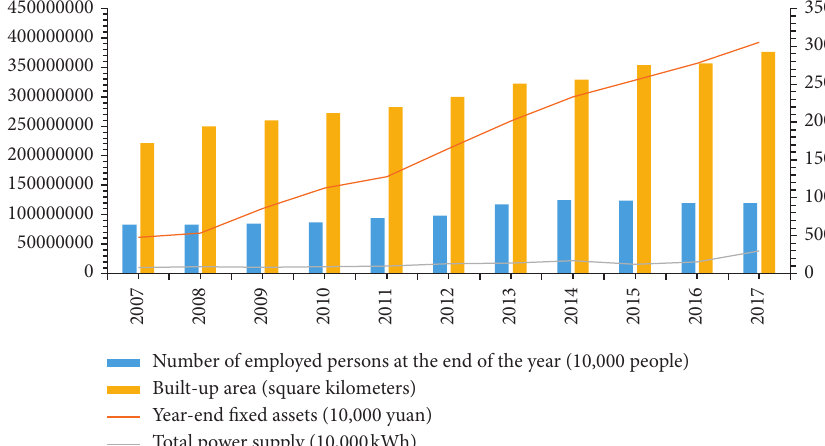
Figure 1: Input factors of prefecture-level cities in Northwest China.